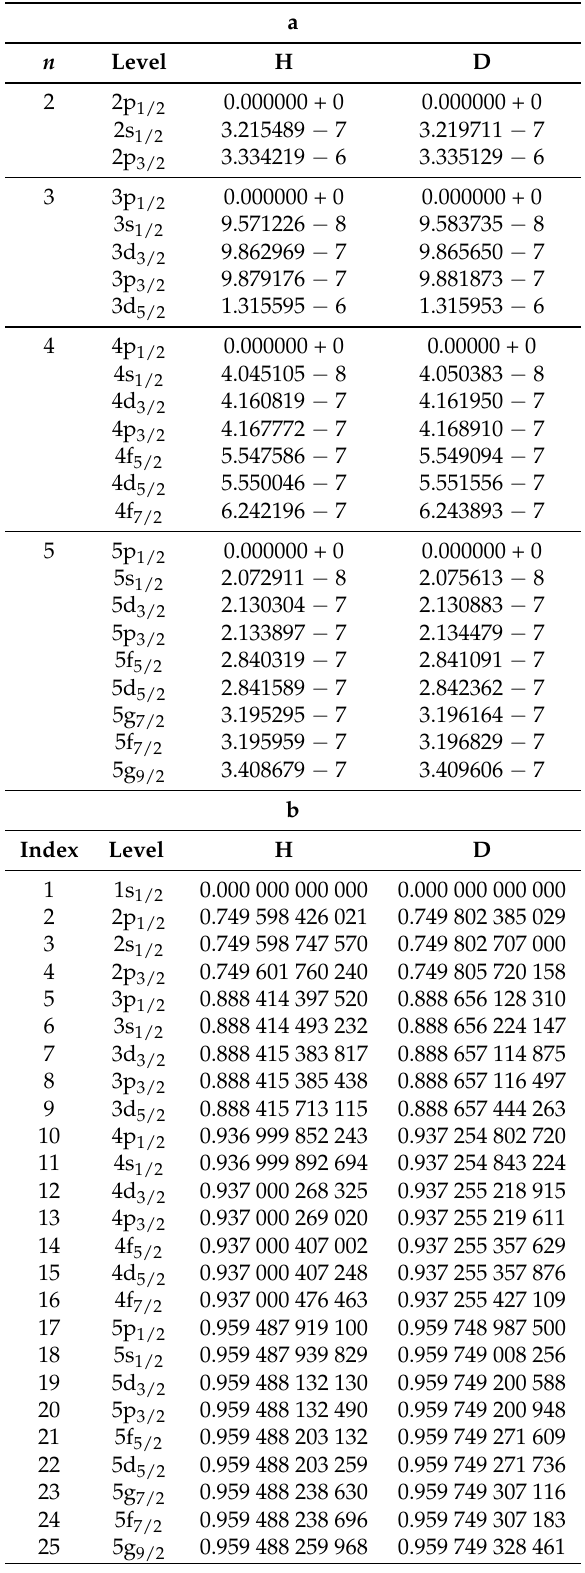
Table 1. (a) Energies (Ryd) for the levels of atomic hydrogen and deuterium with respect to the n p 1/2